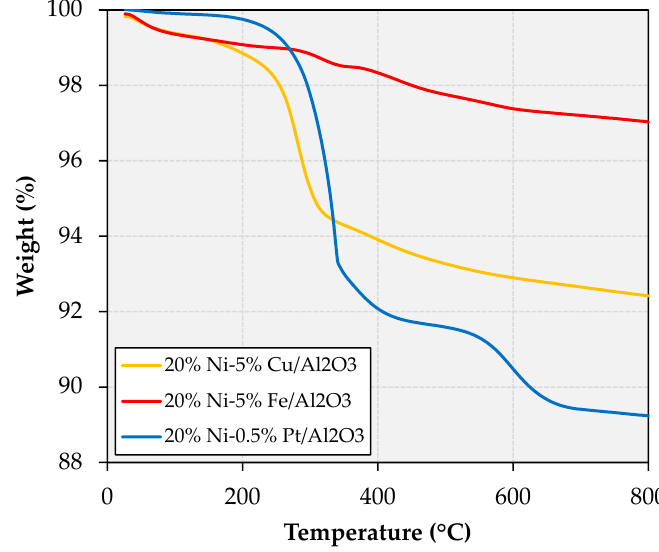
Figure 5. TGA of the spent catalysts recovered from the deoxygenation experiments.